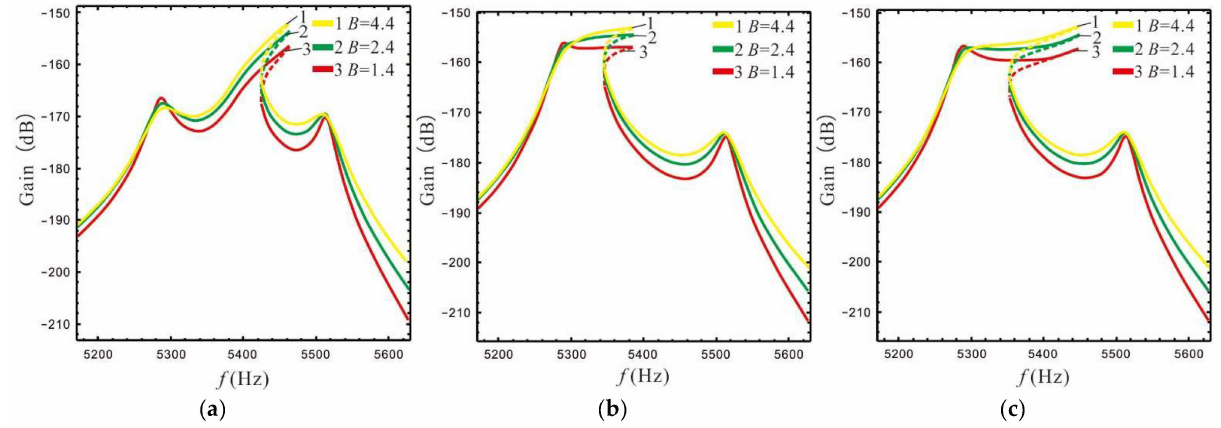
Figure 12. The shape of the frequency response curve is affected by LR: ( a ) ω x = 5400 × 2 π k d = 12.2,